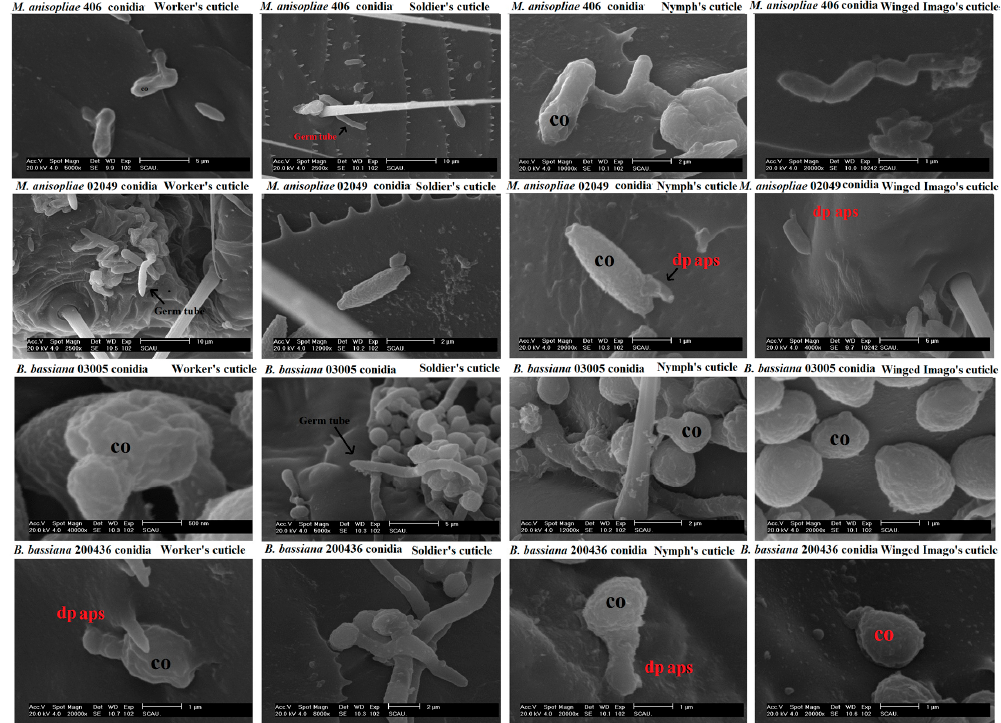
Figure 3. SEM used for the detection of growth patterns of tested isolates of entomopathogenic fungi on the cuticle of workers, soldiers, nymphs and winged imagoes of C. formosanus Shiraki. dp aps stands for directly-penetrating appressorium-like structure; co stands for unipolar-germinated conidium.